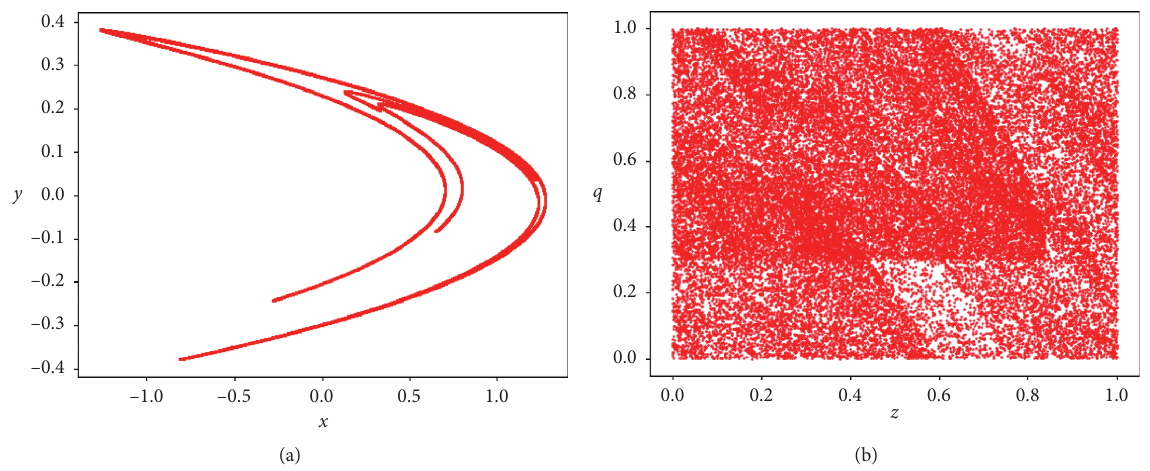
Figure 8: Trajectories of (a) Henon and (b) NHenon.